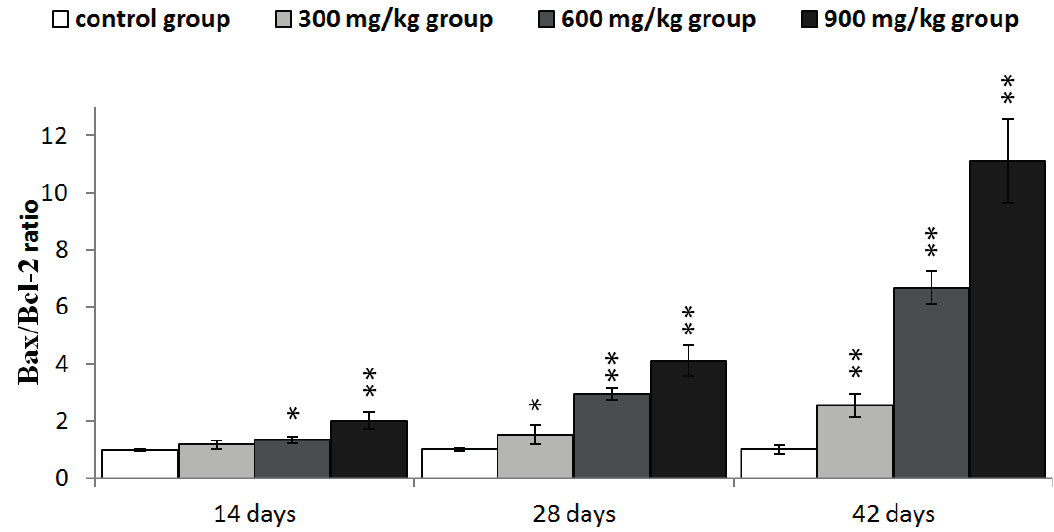
Figure 13. The ratio of Bax/Bcl-2 mRNA expression in the kidney. Data are presented with the mean ± standard deviation ( n = 5); * p < 0.05, compared with the control group; ** p < 0.01, compared with the control